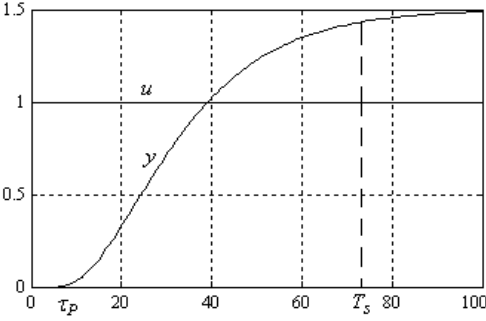
Figure 9. Process response to a unit step